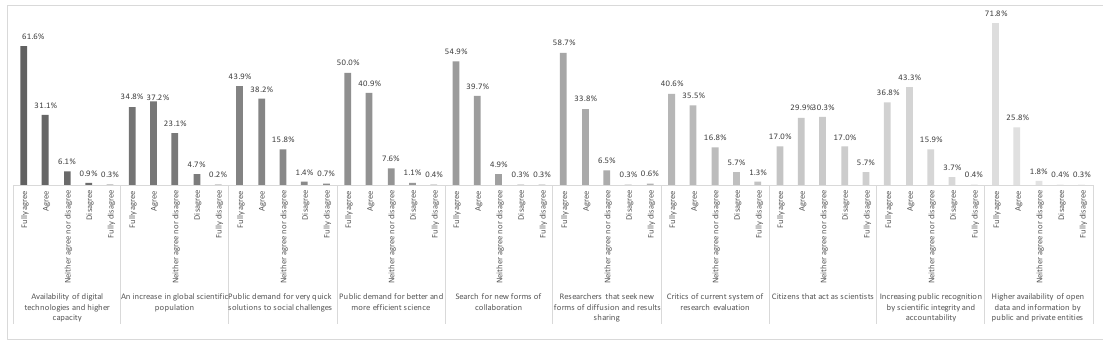
Figure A1. The main drivers of open science, according to Colombian researchers.